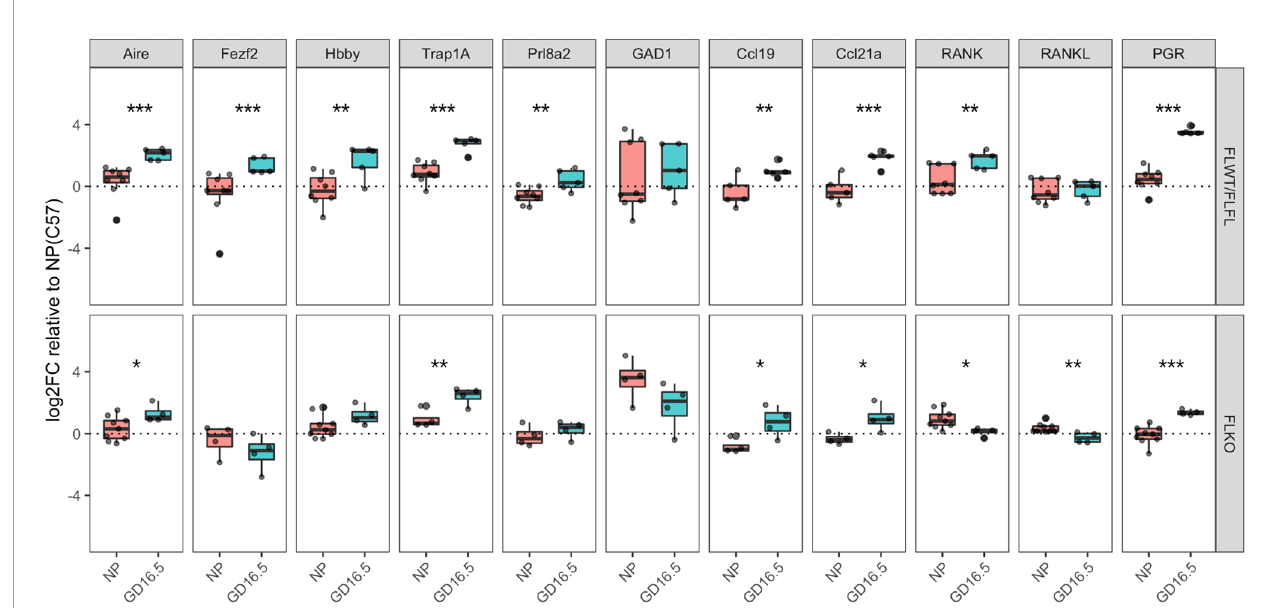
FIGURE 6 | Pgr d/d thymus show unchanged expression of Fezf2 , involved in self-antigen expression and decreased expression of Tnfrsf11a (RANK), involved in mTEC maintenance. Comparison of gene expression in the thymus of Pgr f/+ or Pgr f/f (FLWT/FLFL) and Pgr d/d (FLKO) females between non-pregnant (NP) and GD16.5 of pregnancy. Delta CT was calculated using Gapdh as housekeeping gene. Delta CT of each gene from C57BL/6J WT NP thymus samples were used to calculate delta-delta CT, then the values were Log2 transformed to calculate Log2FoldChange (Log2FC). *p < 0.05, **p < 0.01, ***p < 0.001. Each dot represents one